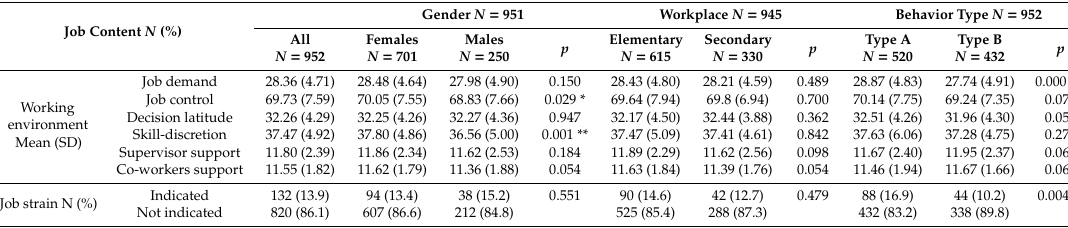
Table 3. Job content questionnaire results stratified by gender, workplace, and behavior